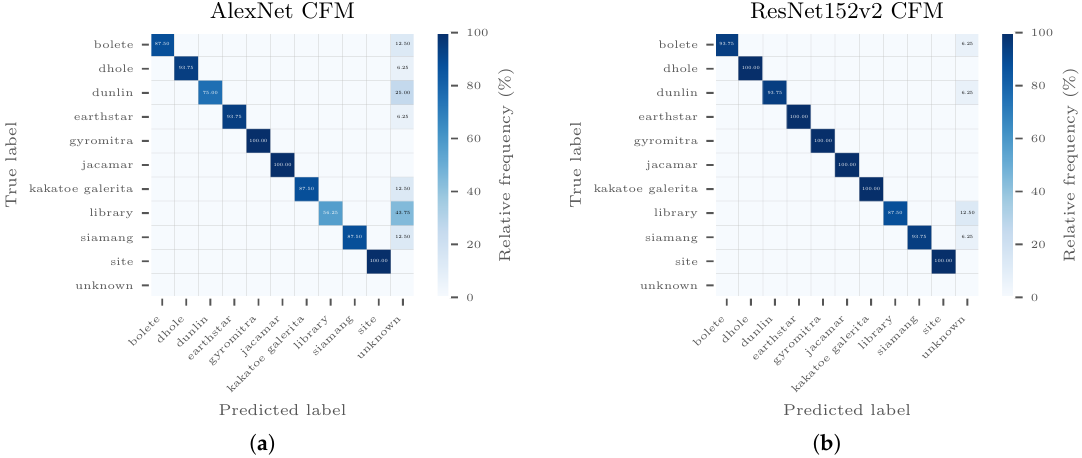
Figure A2. Obtained confusion matrices for CNNs from ILSVRC2012 experiment. The matrix in ( a ) was derived from AlexNet classification results. ( b ) is ResNet’s CFM.